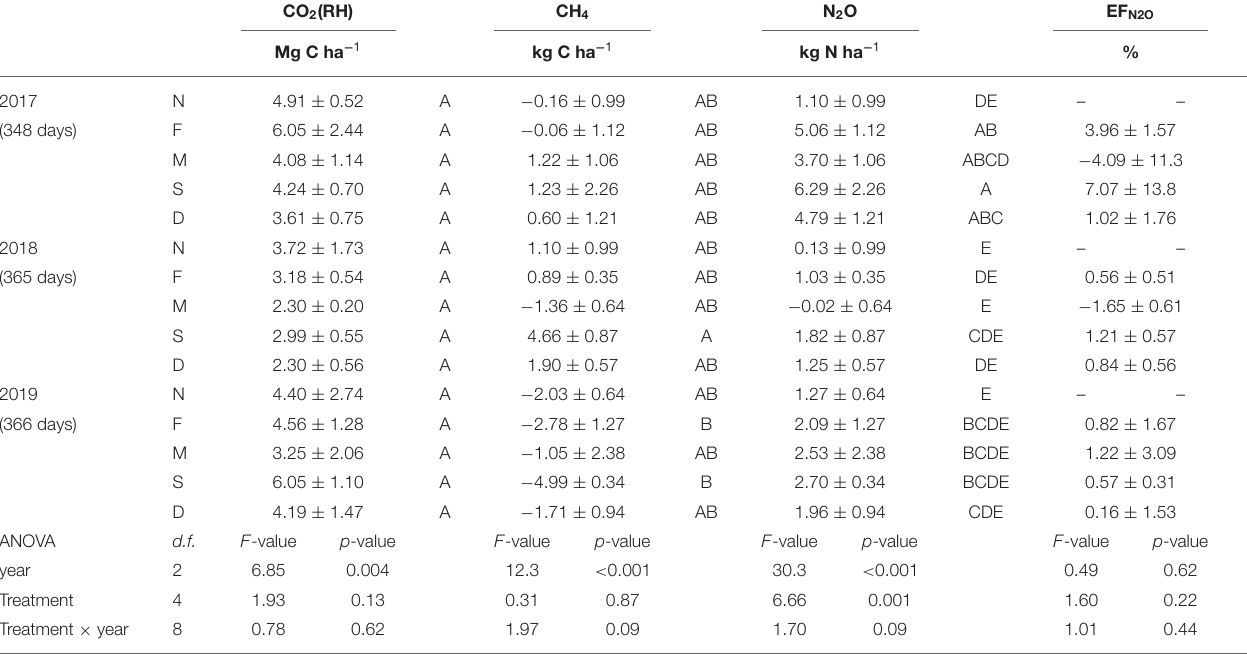
TABLE 3 | Cumulative CO 2 (RH), CH 4 , and N 2 O emissions and the N 2 O emission factor (EF N2O ) for each year.